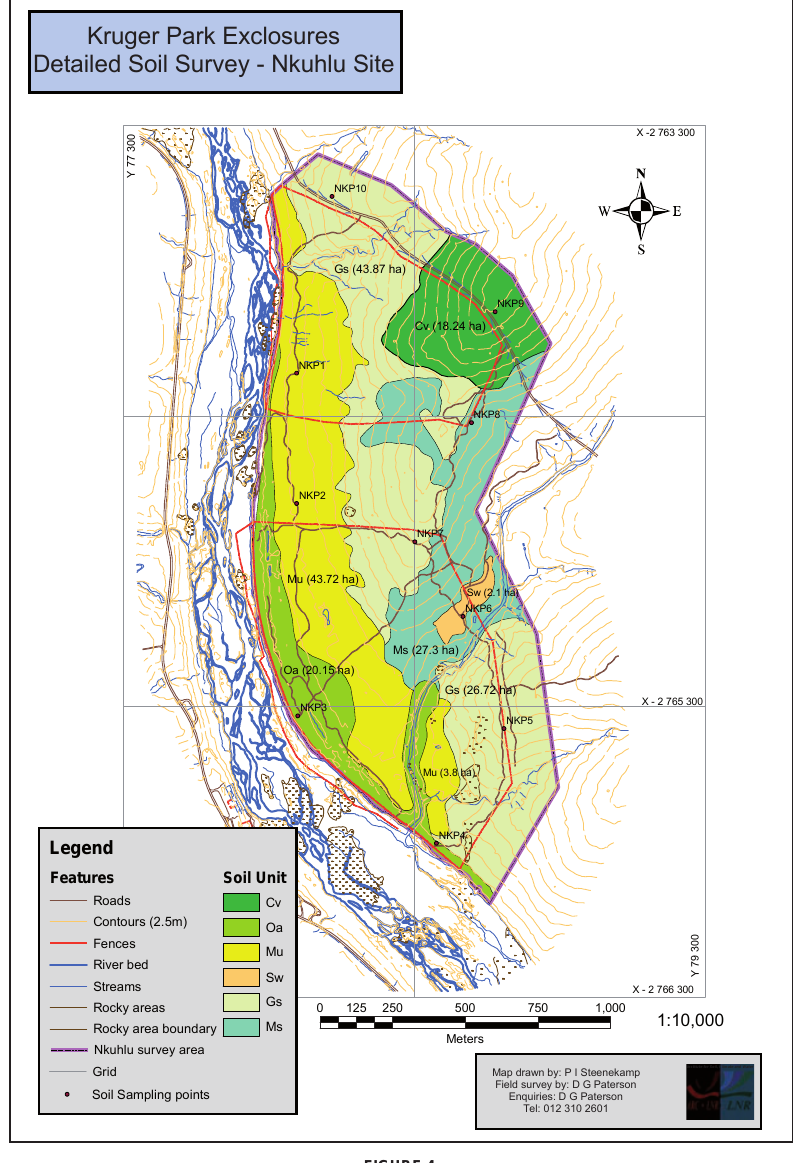
Figure 4 Soil map of the Nkhuhlu exclosure site (courtesy of ARC-Institute for Soil, Climate and Water